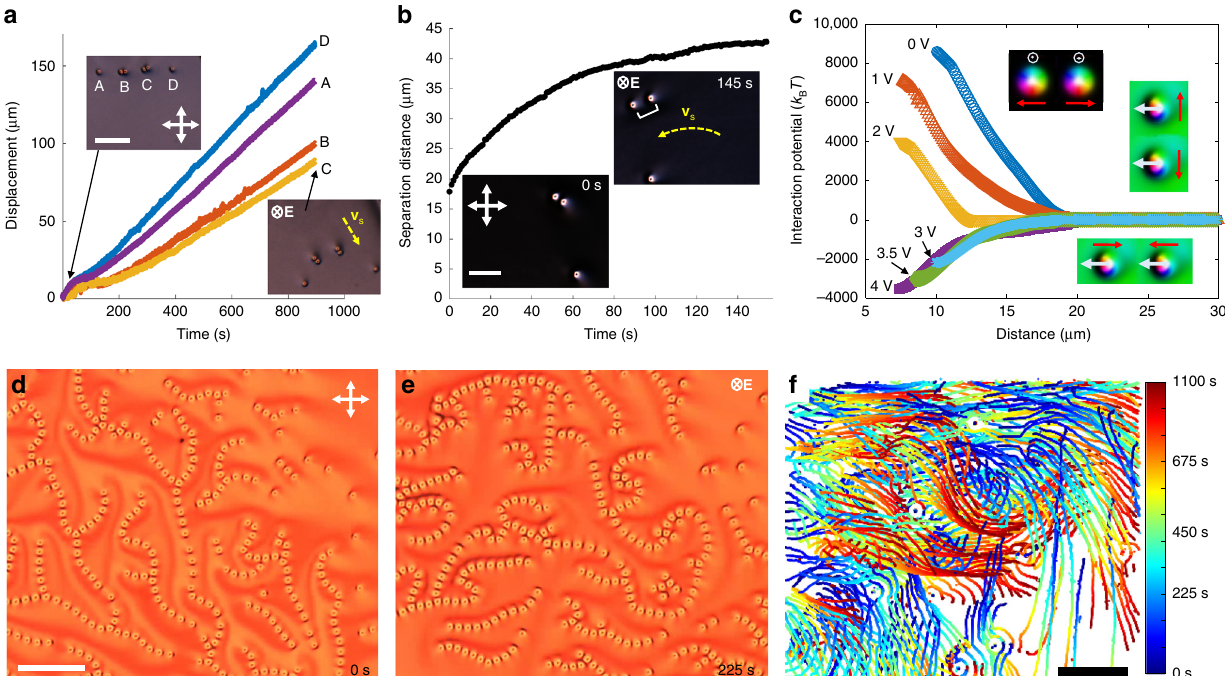
Fig. 2 Pair interactions and motions of individual and two-to-hundreds assemblies of skyrmions. a Comparison of motions of individual and pairs of skyrmions labeled as in the video frames shown in insets. Applied voltage is U = 4.5 V, oscillated at f = 2 Hz; high-frequency 1 kHz carrier signal is used (see Methods), indicating that these motions are not caused solely by the dynamics of ions 24 . The scale bar is 100 µ m . b Pair separation distance versus time during skyrmion motion along the arched trajectories, with insets showing skyrmions in the fi rst and last frames and the pair separation distance labeled on the last frame. Motion was powered by U = 4.5 V and at f = 1 Hz oscillation frequency, with high carrier frequency of 1 kHz. Velocity directions v s are marked in insets of a , b with yellow dashed arrows. The scale bar is 50 µ m. c Pair interaction potential for skyrmions in motion at various voltages and at f = 75 Hz. Insets show smoothly colored simulated n ( r ) con fi gurations that follow the color scheme in Fig. 1g and reveal the presence of attractions or repulsions. Gray arrows mark the preimage vectors and red arrows represent attractive or repulsive forces between skyrmions. d , e Frames from video showing temporal evolution of chains with hundreds of skyrmions at U = 4.2 V oscillated at f = 2 Hz. f Time-colored trajectories representing skyrmion motions over a time period of 1100 s, with the right-side inset showing the time-color scheme. The scale bars in d , f are 100 µ m. The chiral LC is MLC-6609 doped with left-handed chiral additives a , b ZLI-811 and d , e QL-76. White double arrows denote crossed polarizers for all micrographs in this fi gure. E is marked in e and in the last frame of insets in a , b . The elapsed time is marked in the bottom-right of